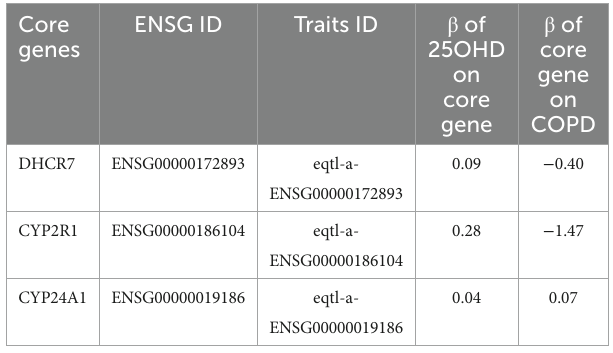
TABLE 1 The effect of core genes involved in the process of vitamin